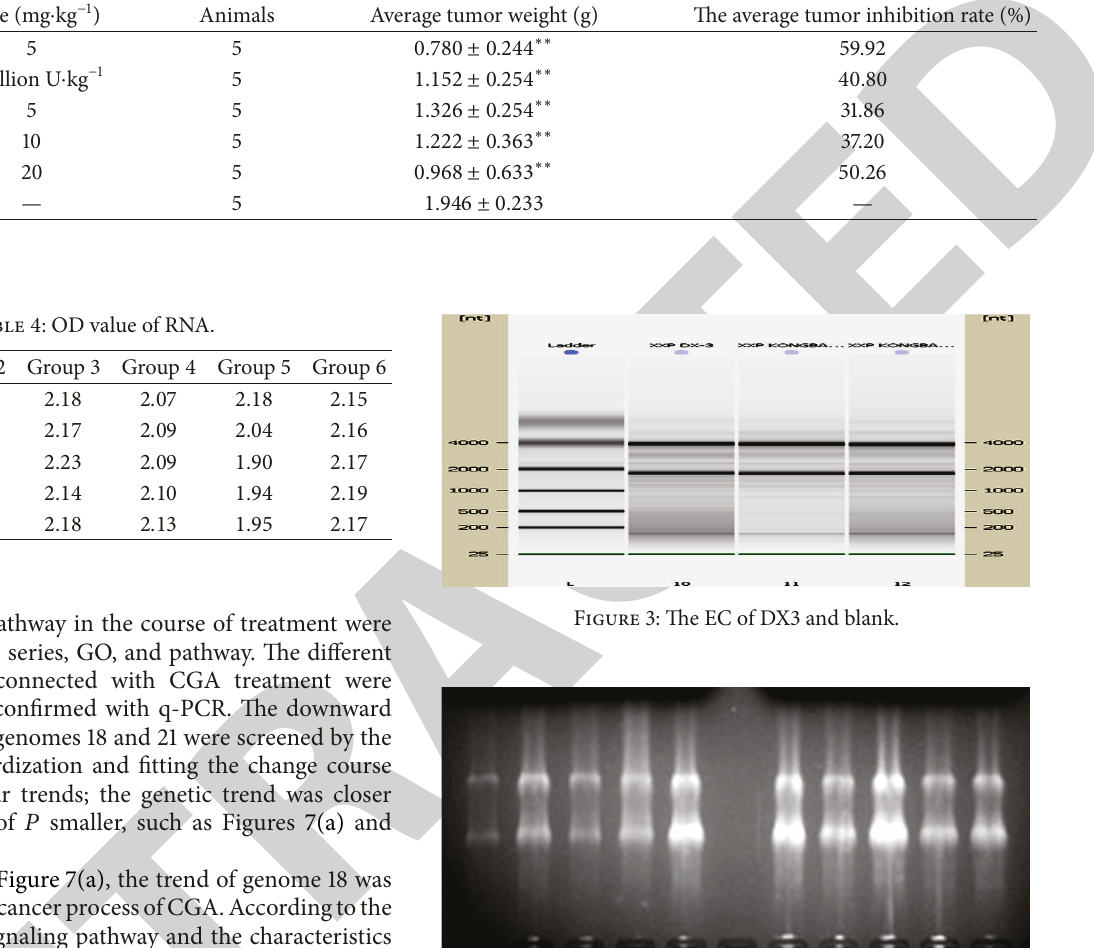
Table 3: Results of CGA suppression of the mice breast cancer.